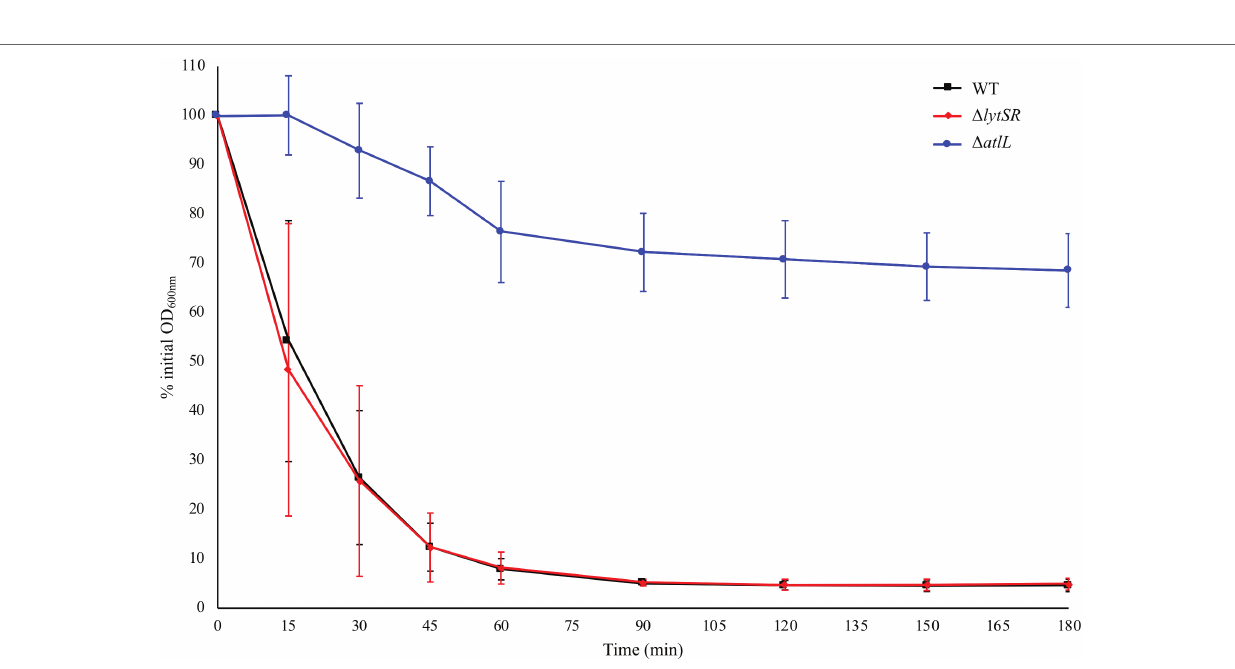
FIGURE 2 | Triton X-100 autolysis assays of S. lugdunensis WT and derivative ( Δ lytSR and Δ atlL ) strains. Bacterial cells were collected from early-exponential growth (OD 600 nm = 0.7) and resuspended in an equal volume of buffer containing 0.05% Triton X-100. The rate of autolysis was monitored at OD 600 nm . The S. lugdunensis atlL deletion mutant was used as a control for resistance to autolysis. Error bars represent the SD of three independent